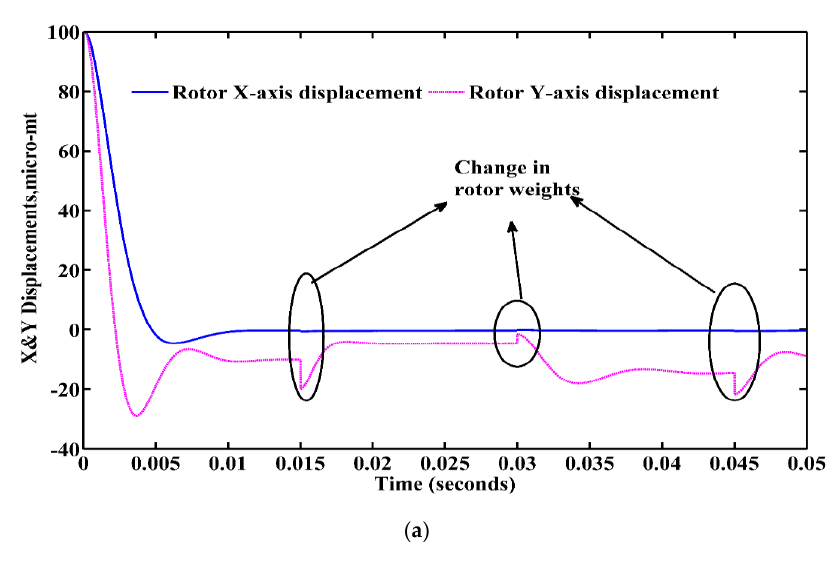
Table 4. Rotor reference displacements with respect to time in all